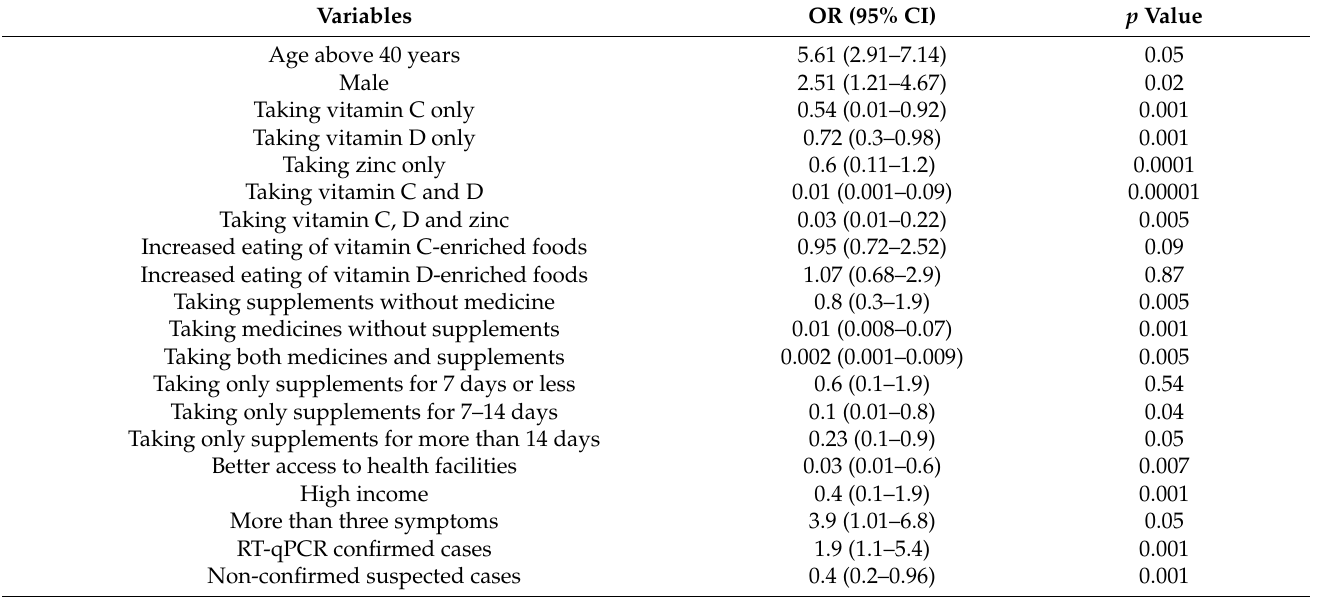
Table 5. Impact of vitamins and different variables on the development of the severity of COVID-19 among